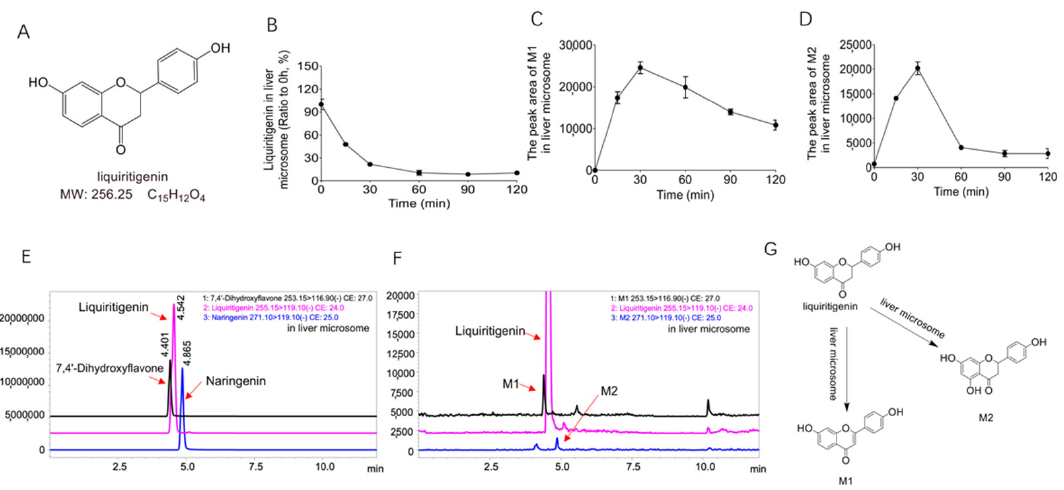
Figure 1. The metabolites of liquiritigenin from liver microsomes. ( A ): The chemical structure of liquiritigenin; ( B ): the relative abundance curve of liquiritigenin incubated with rat liver microsomes at different time points (0 min, 15 min, 60 min, 90 min, and 120 min); ( C , D ): relative abundance curves of metabolites M1 and M2 after incubation with rat liver microsomes for different lengths of time (0 min, 15 min, 60 min, 90 min, and 120 min); ( E ): extracted ion chromatograms (EICs) of the standard liquiritigenin, 7,4 ’ -dihydroxyflavone, and naringenin; ( F ): EICs of liquiritigenin and its metabolites after 60 min of liver microsomal metabolism; ( G ): metabolic pathway of liquiritigenin in liver microsomes (liquiritigenin produces M1 and M2 in liver microsomes).